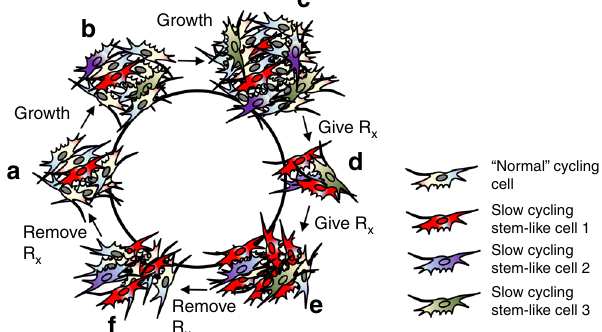
Fig. 3 Minimal residual disease epitomizes the clinical challenge of heterogeneity and tumor plasticity. a A small subpopulation of melanoma cells possess stem-like molecular and biological properties and undergo cellular proliferation at a slower rate than the rest ( b , c ) of the population. d Upon the addition of therapy (Rx), the bulk of the tumor is eliminated, except the stem-like subpopulation (minimal residual disease). e Under continuous therapy, the stem-like cells continue to proliferation and have the capacity to birth non-stem-like progeny. f Upon termination of therapy, the stem-like cells will again become scarce as the “ normal ” cycling cells continue to proliferate at a higher